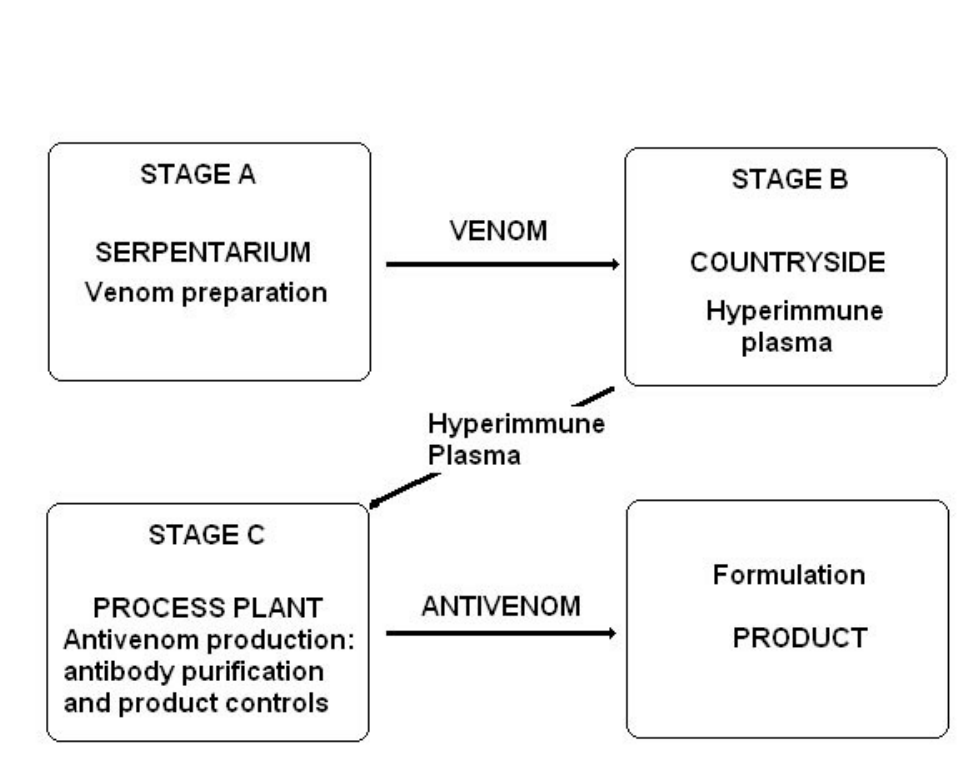
Figure 1: Stages in overall snake antivenom